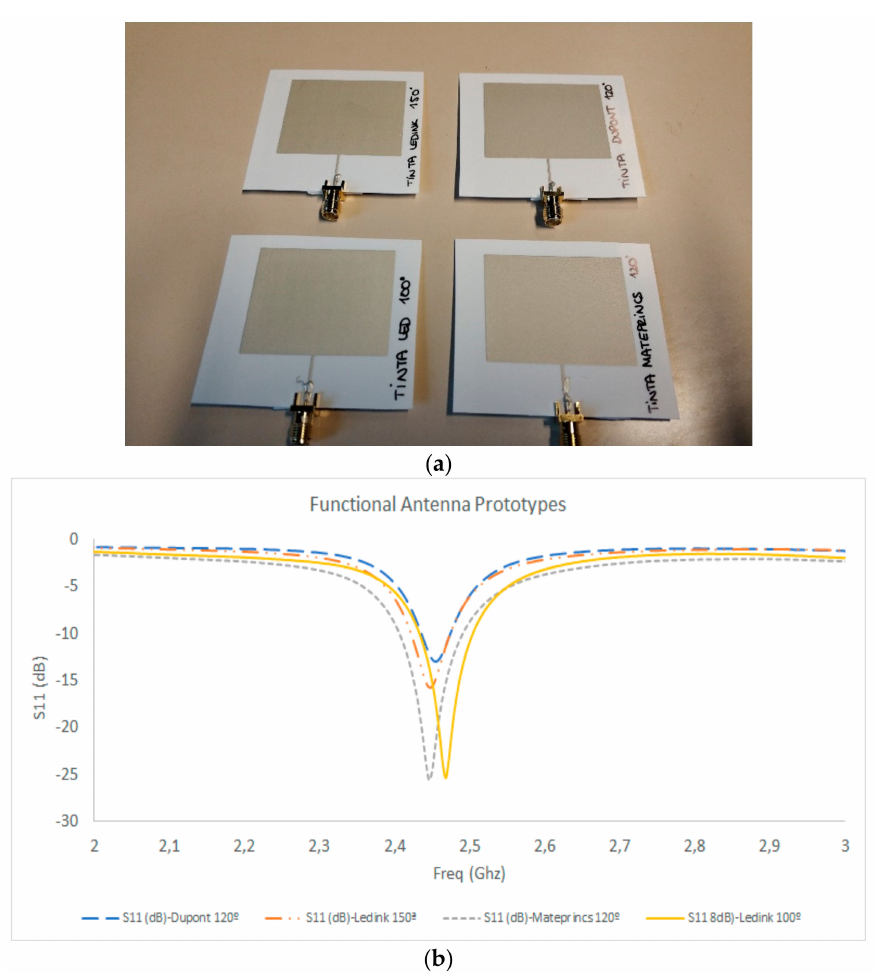
Figure 6. ( a ): Fabricated prototypes for di ff erent ink types and temperature conditions. ( b ): S11 parameter measurement